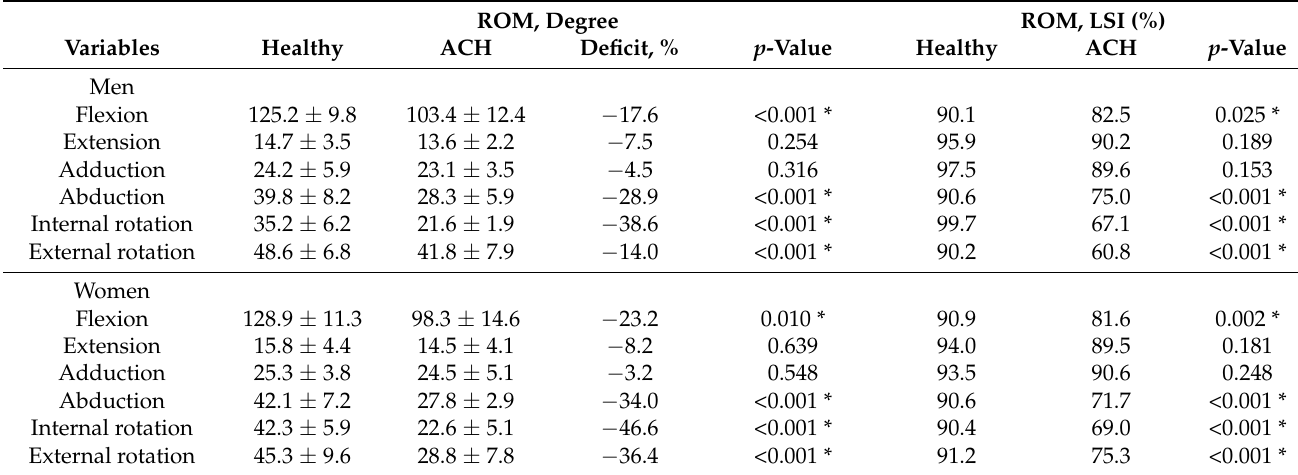
Table 2. Range of motion in healthy controls and patients with ACH.